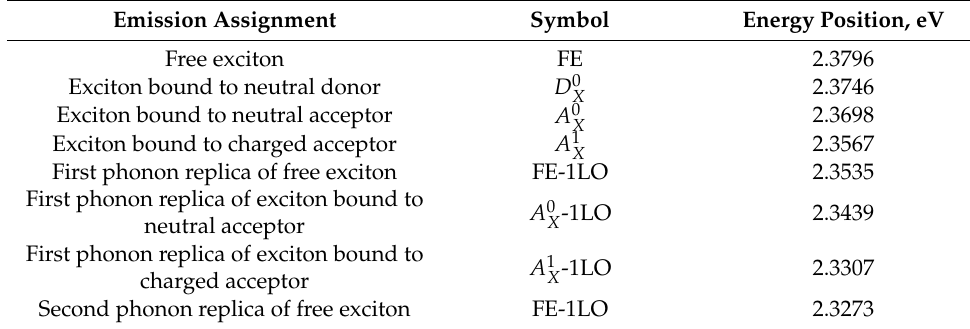
Table 1. Assignment of ZnTe exciton luminescence bands, T = 20 K